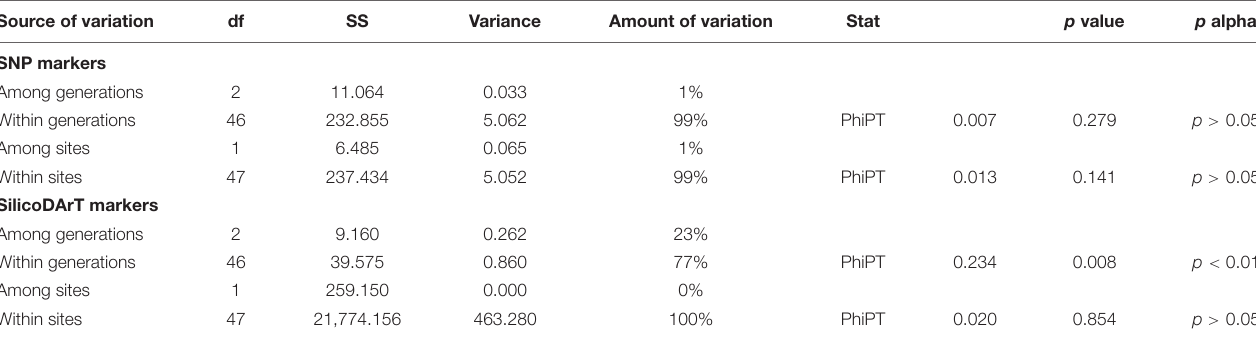
TABLE 1 | Analyses of molecular variance (AMOVA) conducted for 49 Medemia argun samples based on SNP and SilicoDArT markers, including three age classes (generations) and two collection sites. Source of variation df SS Variance Amount of variation